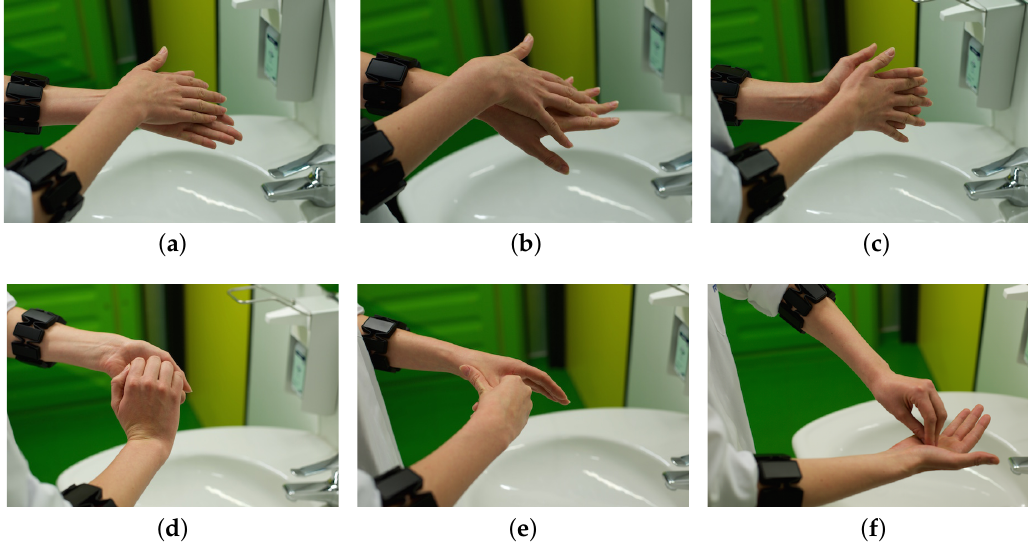
Figure 1. Hand hygiene movements according to WHO: ( a ) G1: cleaning of palms; ( b ) G2L, G2R: cleaning the back of the hands and between fingers; ( c ) G3: cleaning palm and between fingers; ( d ) G4: cleaning back of fingers; ( e ) G5L, G5R: Cleaning thumbs; and ( f ) G6L, G6R: cleaning finger tips and nails. L and R indicate leading left and right hand,